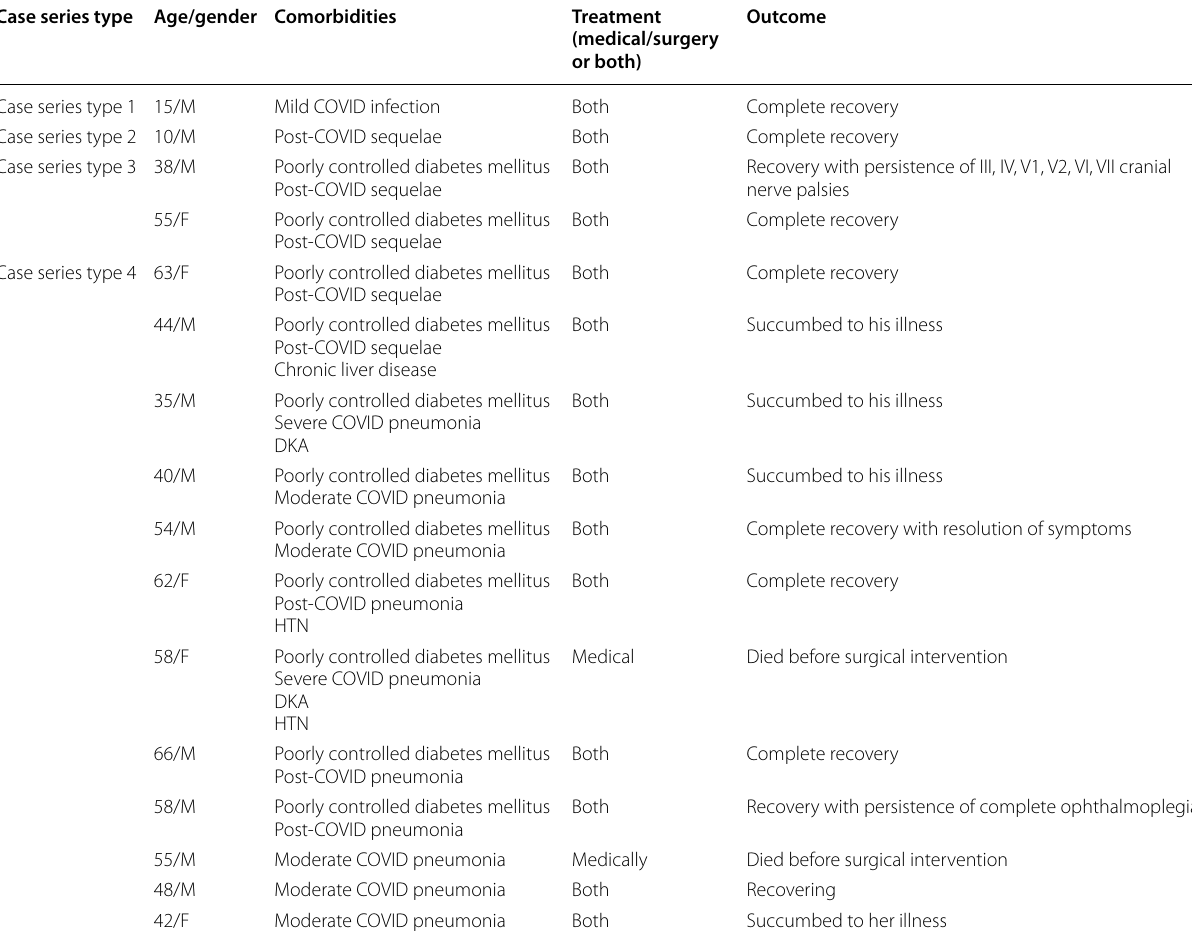
Case series type Age/gender